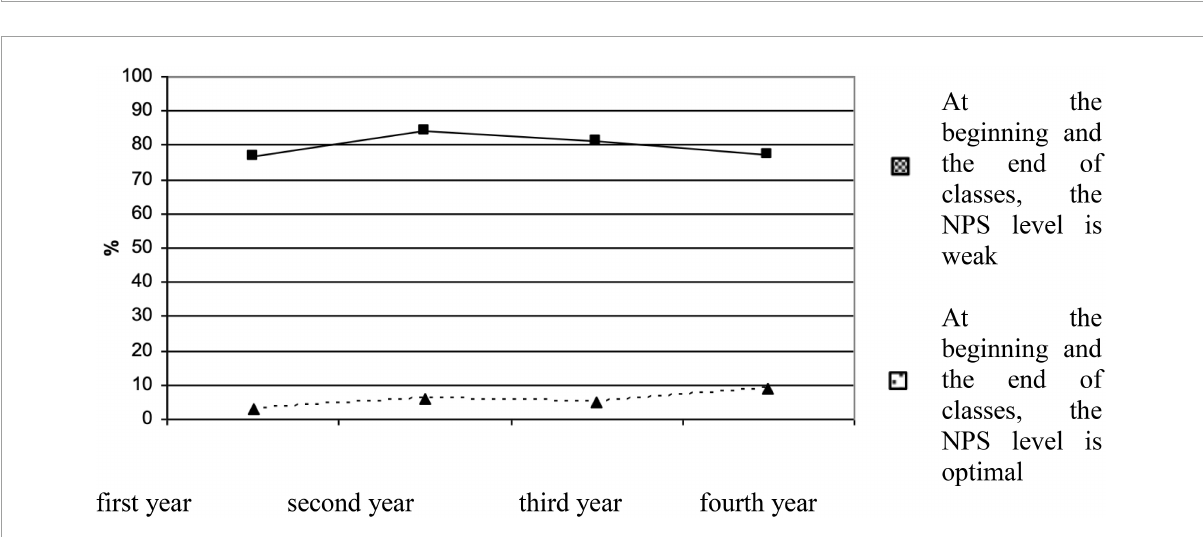
FIGURE4 Frequency of occurrence of different dynamic patterns of the zero shift in the level of neuropsychic strain among psychology students of the second age subgroup (in